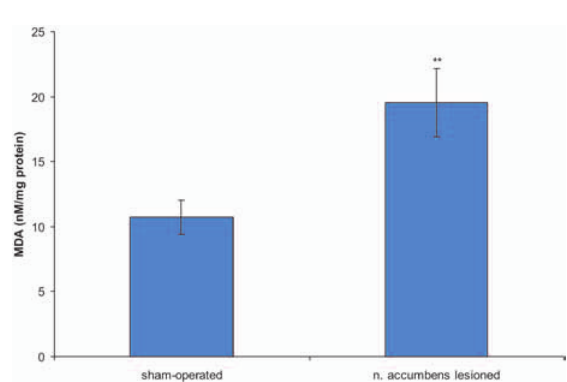
Figure 4. Effects of 6-OHDA-induced lesion of the NAcc on MDA level from the temporal lobe. The values are mean